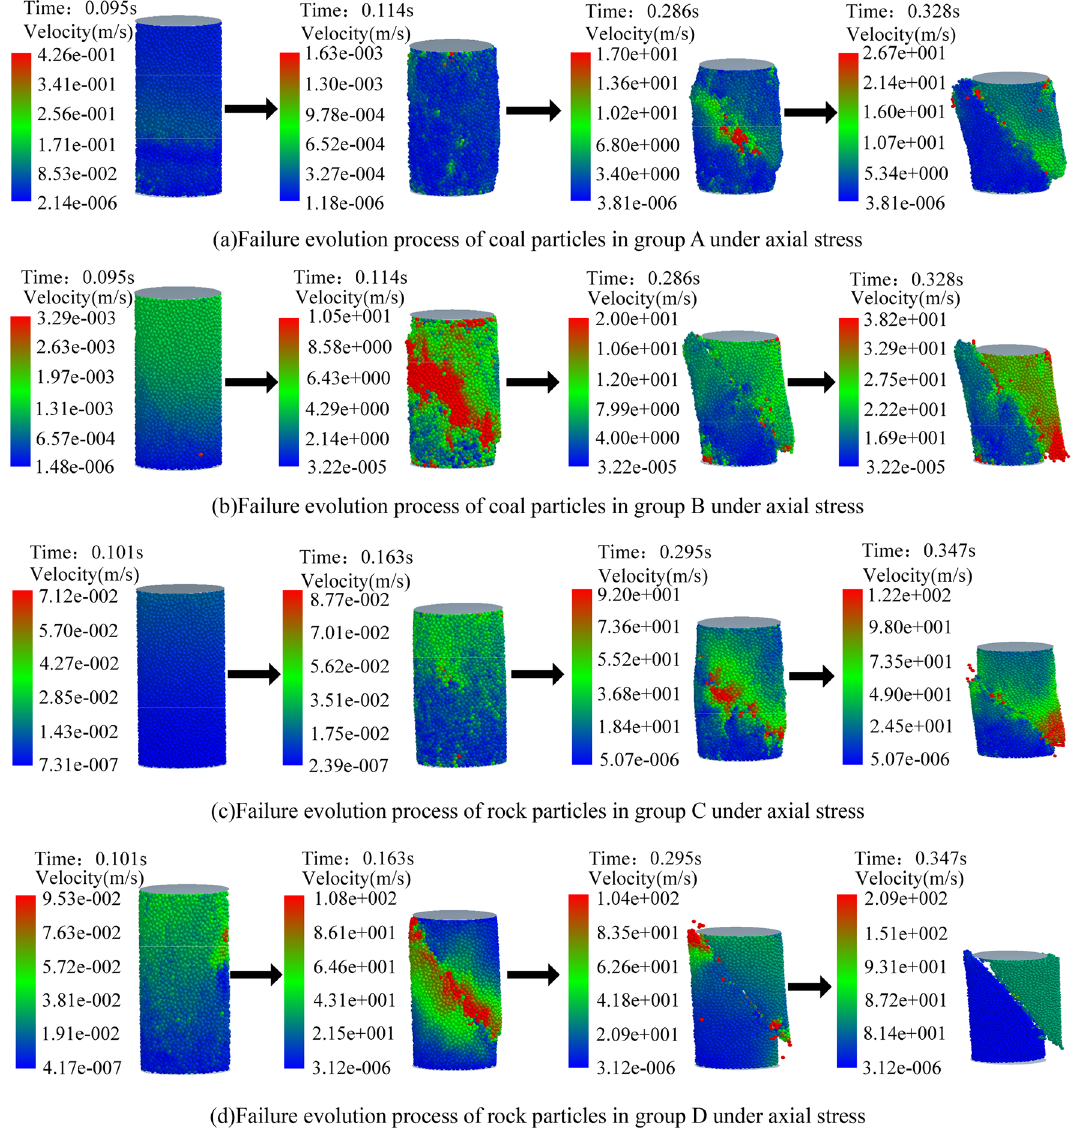
Figure 6. Failure evolution process of coal and rock samples.